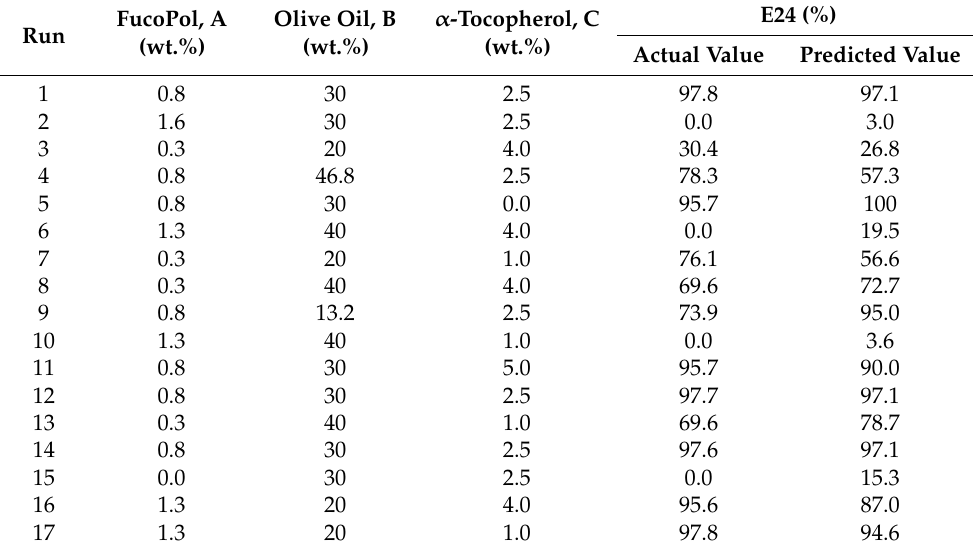
Table 4. Central composite design (CCD) with studied variables (A: FucoPol, B: Olive oil, C: α - tocopherol), experiment and theoretically predicted values E24. FucoPol, A Olive Oil, Run (wt.%)